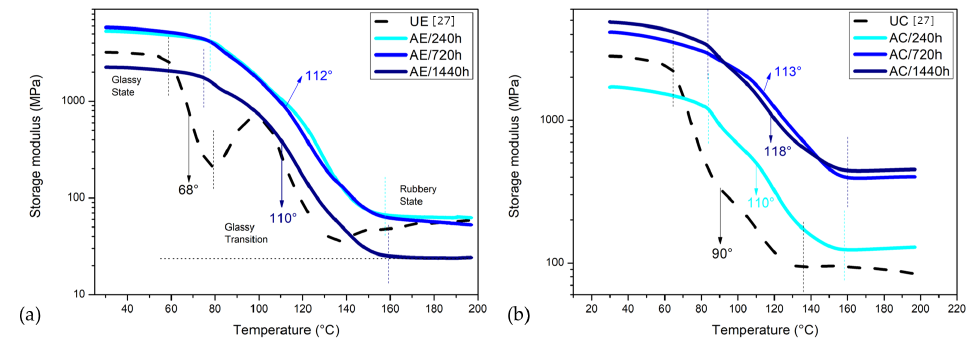
Figure 10. DMA storage modulus (E (cid:48) ) curves for ( a ) epoxy resin and its composite unaged and water-immersion-aged ( b